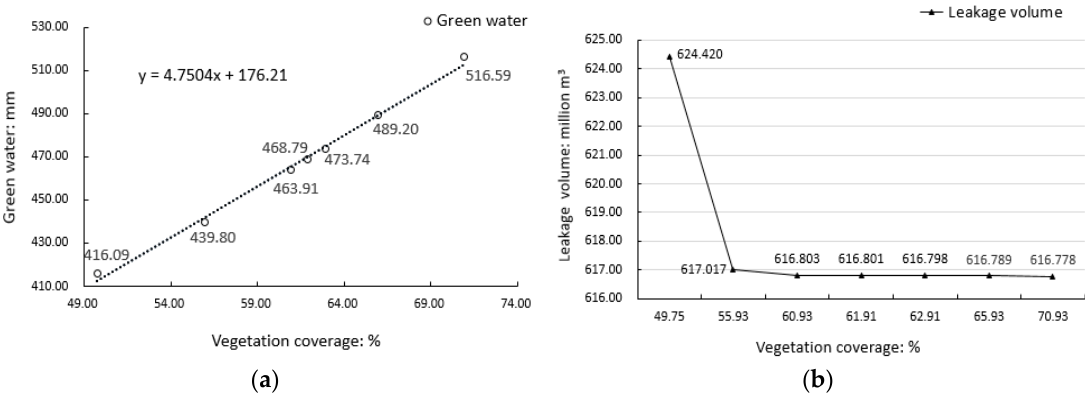
Figure 9. ( a ) Linear dependence relation between vegetation coverage and green water; and ( b ) telationship between vegetation coverage increase and leakage reduction.